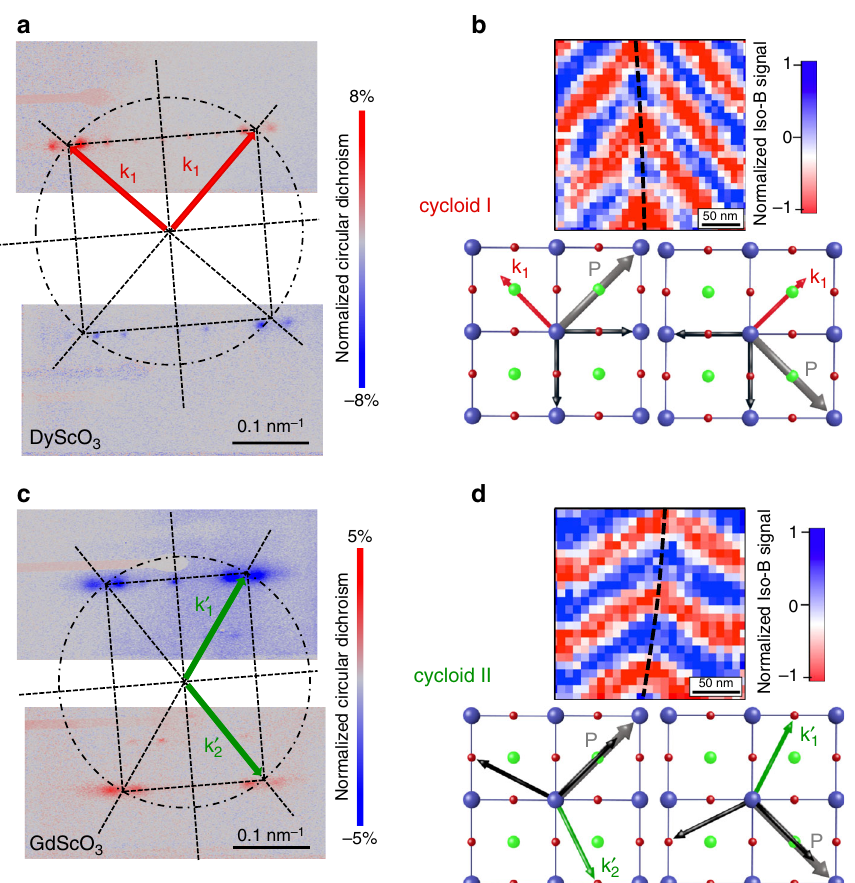
Fig. 4 The two types of spin cycloids in real and reciprocal spaces. a Resonant X-ray elastic scattering at the Fe L -edge for BiFeO 3 grown on DyScO 3 . The square pattern indicates a bulk-like cycloid (cycloid I) with propagation vectors aligned 90 degrees from each other. b Corresponding NV magnetometry image zoomed in, with the propagation vectors sketched for both polarisation variants. c Resonant X-ray elastic scattering at the Fe L -edge for BiFeO 3 grown on GdScO 3 . The rectangular pattern corresponds to the cycloid II with propagation vectors lying at 110 ± 5 degrees from each other. d Corresponding NV magnetometry image zoomed in, with the propagation vectors sketched for both polarisation variants. The dashed lines in b , d are guides to the eyes, re fl ecting a change of the cycloid propagation vector associated to the ferroelectric domain walls.